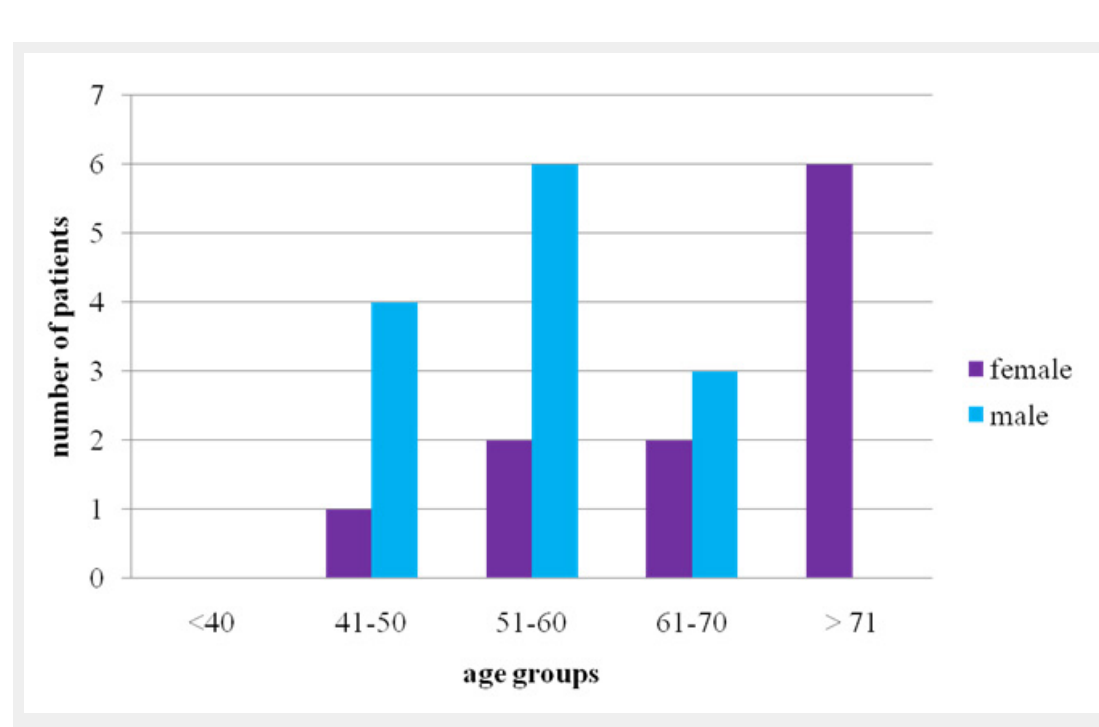
The distribution of the study population by age and gender. With increasing age, the amount of female participants increased, accounting for all of the participants in the age group >71 years.